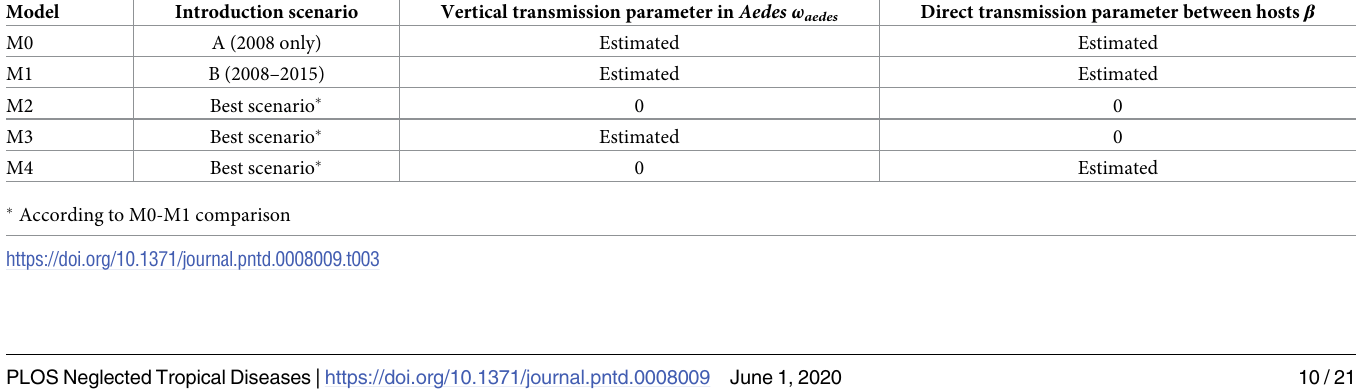
Table 3. Model selection: definition of the compared models.